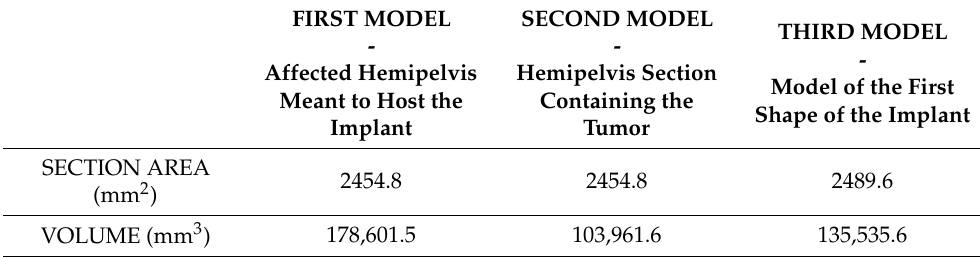
Table 1. Area of the cutting sections and volume of the final models